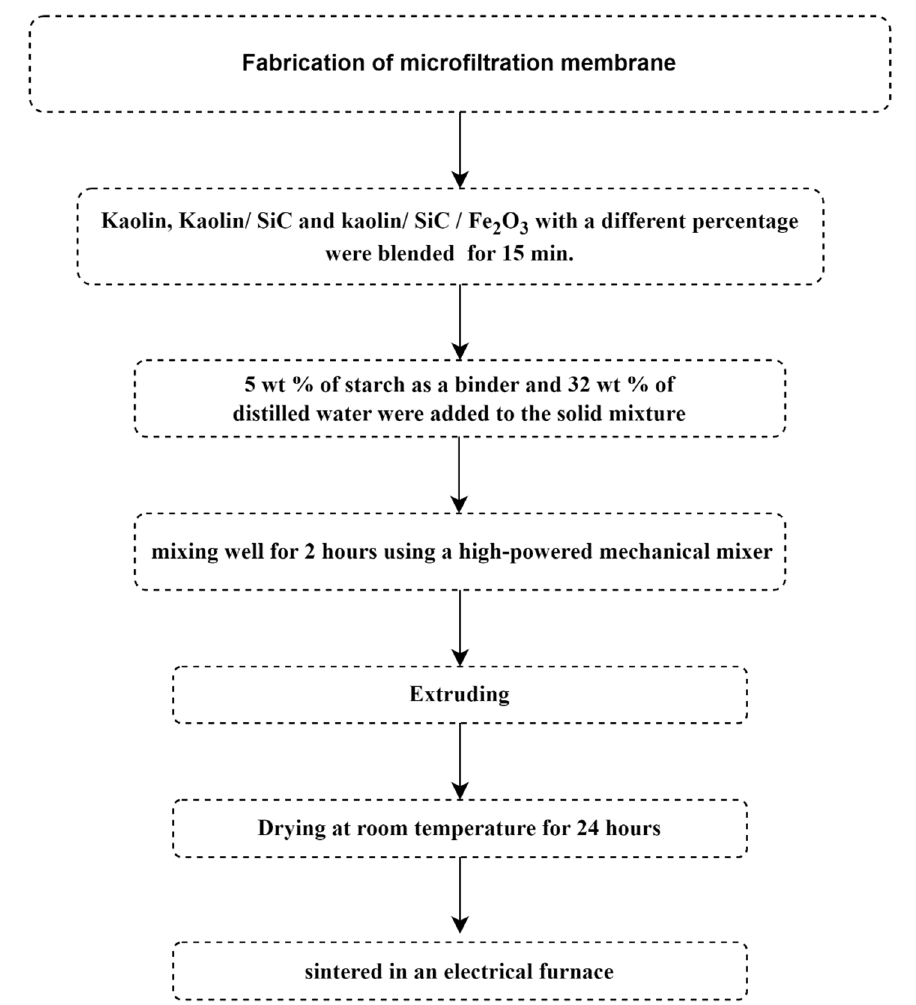
Figure 1. Schematic of preparation steps of microfiltration membranes. Table 3. Characteristics of fabricated ceramic membranes.